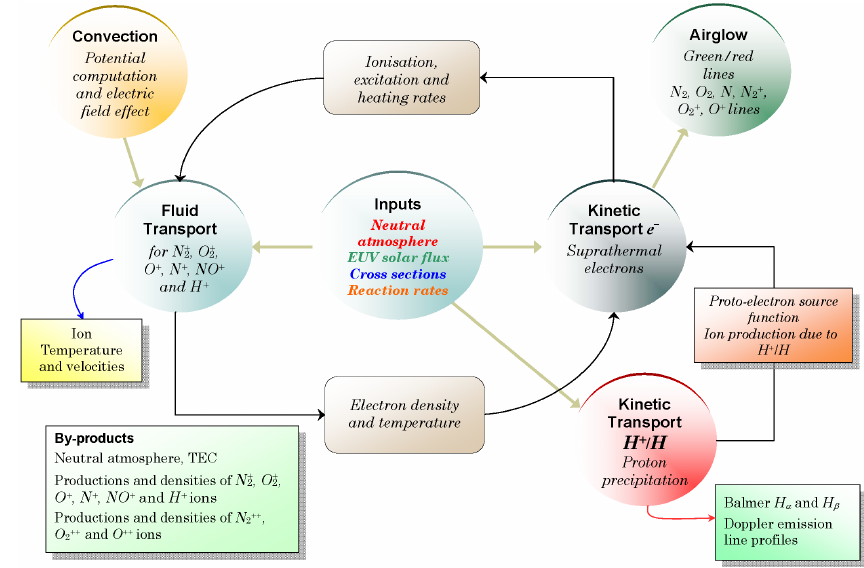
Fig. 1. Architecture of TRANS4, a multicoupled proto-electron kinetic/fluid transport numerical